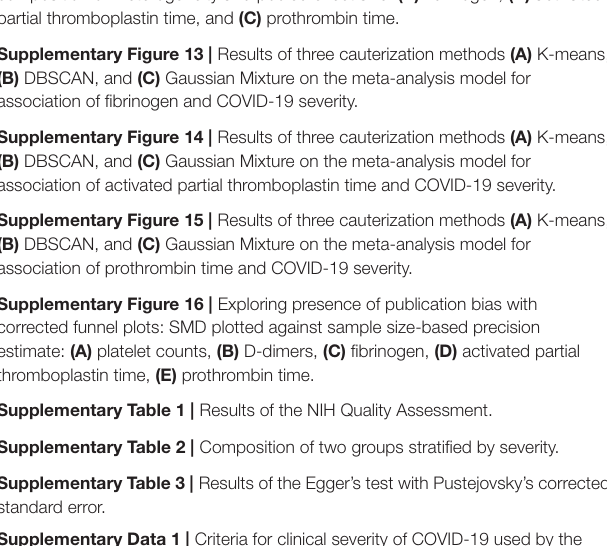
Supplementary Figure 2 | Influence diagnostic of meta-analysis model for the association of platelet count and COVID-19 severity. Supplementary Figure 3 | Influence diagnostic of meta-analysis model for the association of D-dimers concentration and COVID-19 severity. Supplementary Figure 4 | Influence diagnostic of meta-analysis model for the association of fibrinogen and COVID-19 severity. Supplementary Figure 5 | Influence diagnostic of meta-analysis model for the association of activated partial thromboplastin time and COVID-19 severity. Supplementary Figure 6 | Influence diagnostic of meta-analysis model for the association of prothrombin time and COVID-19 severity. Supplementary Figure 7 | Search for influential cases by leave-one-out method in meta-analysis models for the association of (A) platelets count, (B) D-dimers and COVID-19 severity. Supplementary Figure 8 | Search for influential cases by leave-one-out method in meta-analysis models for the association of (A) fibrinogen, (B) APTT and COVID-19 severity. Supplementary Figure 9 | Search for influential cases by leave-one-out method in meta-analysis model for the association of prothrombin time and COVID-19 severity. Supplementary Figure 10 | Forest plots of association of COVID-19 severity and (A) platelet counts and (B) D-dimers with outliers removed. Supplementary Figure 11 | Forest plots of association of COVID-19 severity and (A) fibrinogen, (B) activated partial thromboplastin time, and (C) prothrombin time with outliers removed. Supplementary Figure 12 | Exploring the influence of meta-analysis study composition on heterogeneity and pooled effect size: (A) fibrinogen, (B) activated partial thromboplastin time, and (C) prothrombin time. Supplementary Figure 13 | Results of three cauterization methods (A) K-means, (B) DBSCAN, and (C) Gaussian Mixture on the meta-analysis model for association of fibrinogen and COVID-19 severity. Supplementary Figure 14 | Results of three cauterization methods (A) K-means, (B) DBSCAN, and (C) Gaussian Mixture on the meta-analysis model for association of activated partial thromboplastin time and COVID-19 severity. Supplementary Figure 15 | Results of three cauterization methods (A) K-means, (B) DBSCAN, and (C) Gaussian Mixture on the meta-analysis model for association of prothrombin time and COVID-19 severity. Supplementary Figure 16 | Exploring presence of publication bias with corrected funnel plots: SMD plotted against sample size-based precision estimate: (A) platelet counts, (B) D-dimers, (C) fibrinogen, (D) activated partial thromboplastin time, (E) prothrombin time. Supplementary Table 1 | Results of the NIH Quality Assessment. Supplementary Table 2 | Composition of two groups stratified by severity. Supplementary Table 3 | Results of the Egger’s test with Pustejovsky’s corrected standard